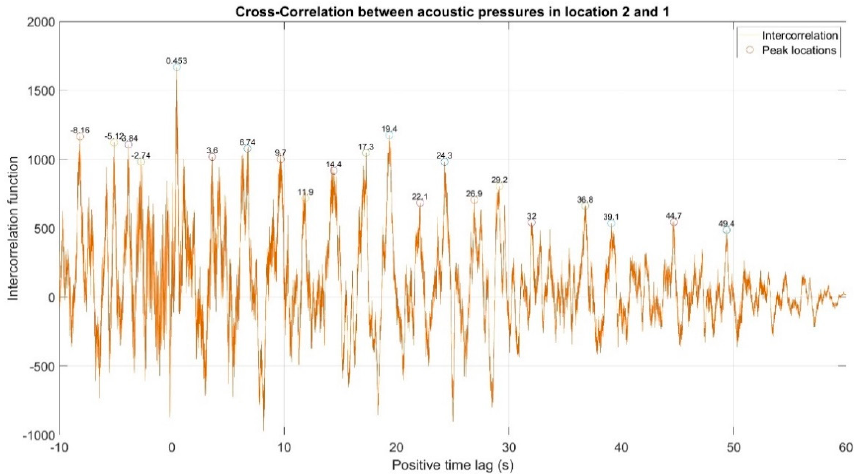
Figure 13. Inter-correlation between acoustic pressures in location 2 and 1. There are several peaks for positive lag. The highest correlation is for lag of 0.45 s.